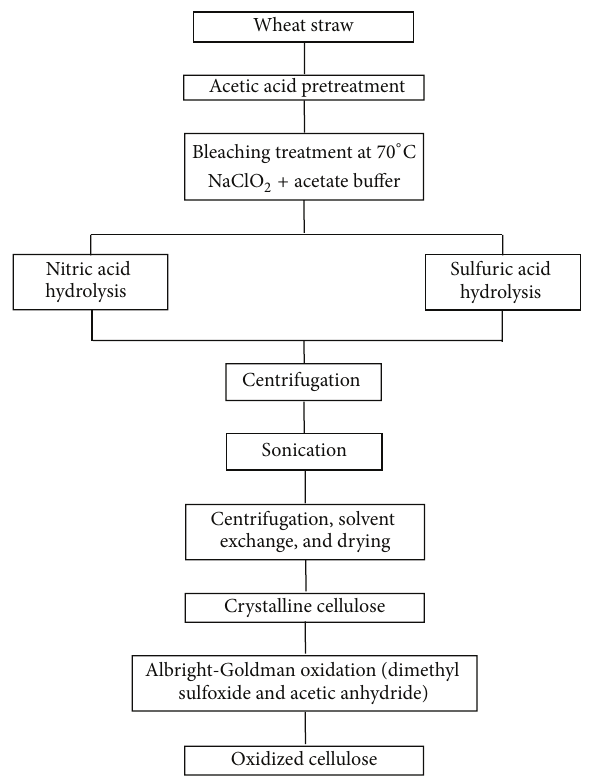
Figure 1: The isolation and chemical functionalization methodol- ogy for the crystalline cellulose isolated from wheat